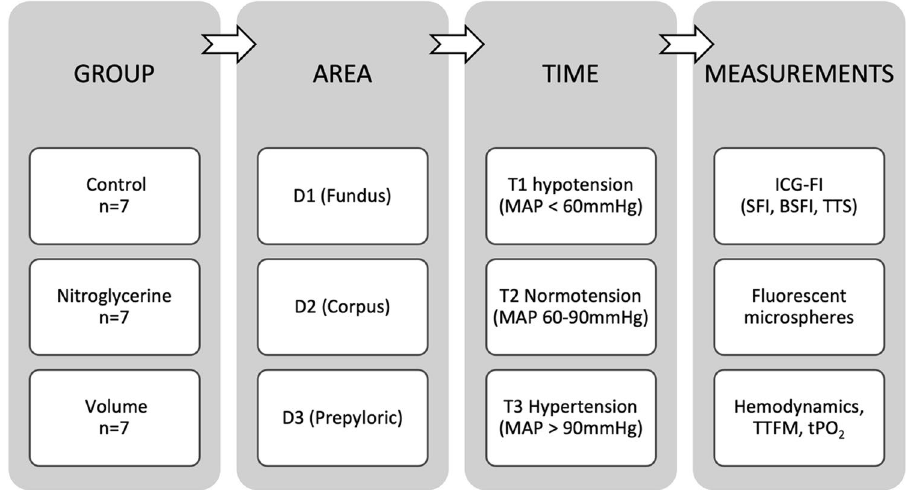
Figure 2. Experimental setting. Three groups were formed from a total of 21 animals: A control group (n = 7), a group with continuous infusion of nitroglycerine (n = 7), and a group with hypervolemia. In each animal, a gastric tube was created and divided into three segments: Gastric fundus (D1), gastric corpus (D2), and prepyloric region (D3). Various measurements were carried out at three predefined times (T1: hypotension, T2: normotension; T3: hypertension): Indocyanine green fluorescence imaging (ICG-FI) with the calculation of slope of fluorescence intensity (SFI), background subtracted fluorescence intensity (BSFI) and time to slope (TTS), application of fluorescent microspheres, continuous measurement of the hemodynamics, transit time flow measurement (TTFM) of the right gastroepiploic arteria and tissue oxygenation (tPO 2 ). MAP mean arterial blood